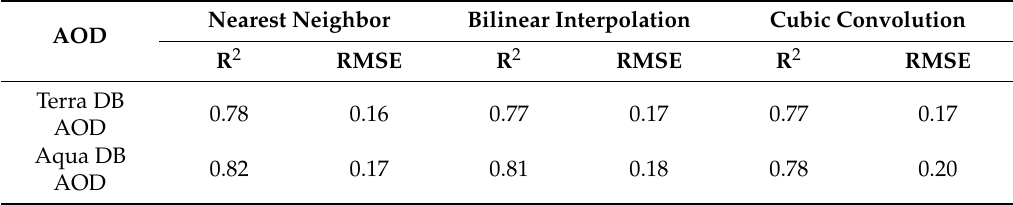
Table A1. Validation summary of the resampled 3-km DB AOD data. Nearest Neighbor Bilinear Interpolation Cubic Convolution AOD